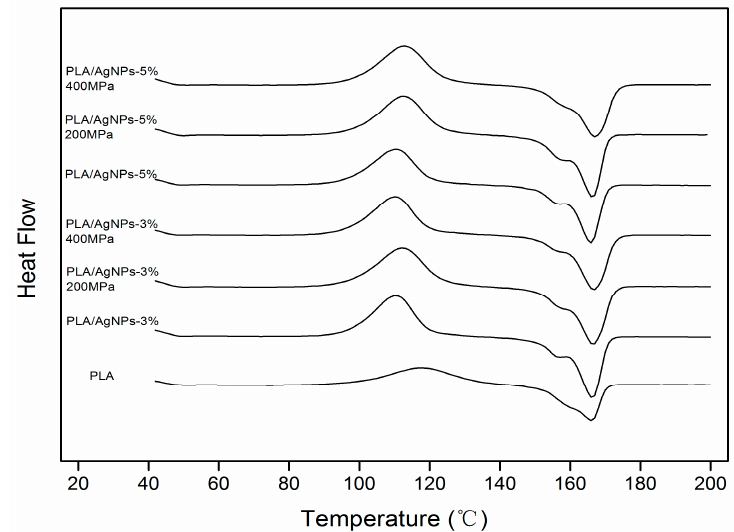
Figure 2. Effect of high pressure treatment on the differential scanning calorimetry (DSC) thermograms of PLA/AgNPs nanocomposite films (PLA film; PLA/AgNPs-3 film treated at 0, 200 and 400 MPa; PLA/AgNPs-5 film treated at 0, 200 and 400 MPa, respectively).